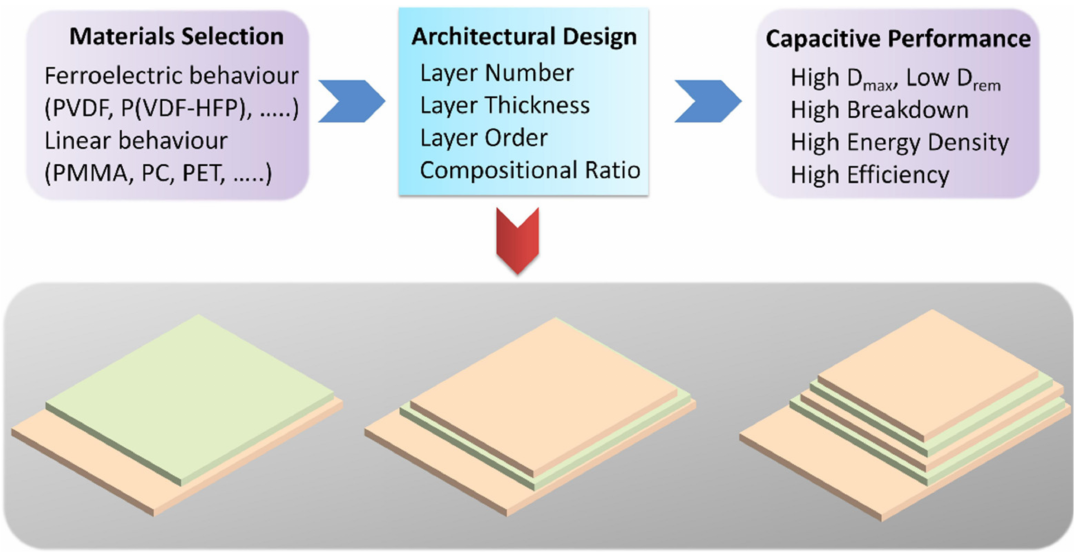
Figure 2. The materials selection, structure design, energy storage performance, and schematic diagram of hierarchically structured all-organic